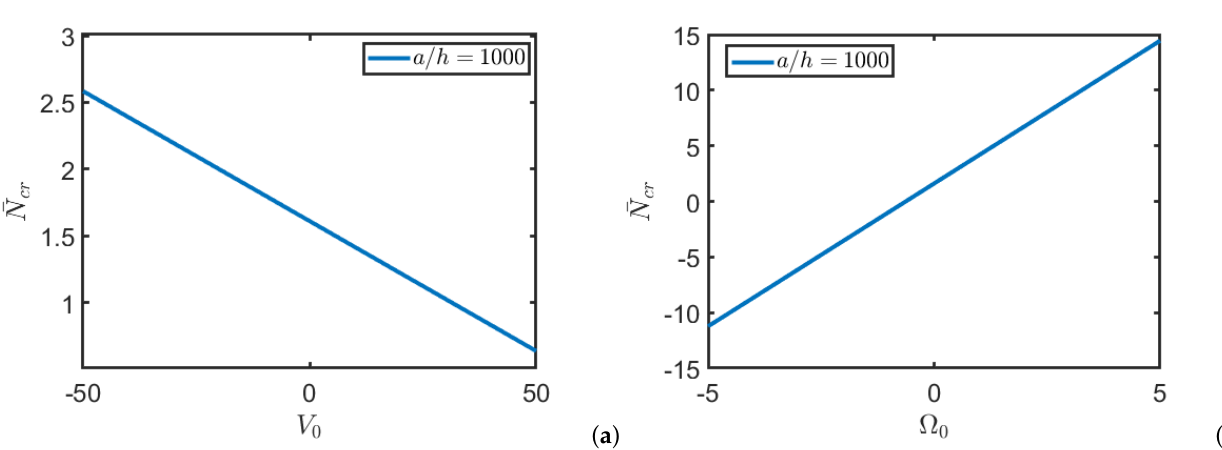
Figure 2. Critical load ¯ N cr of a square Functionally Graded (FG) nanoplate for different values of electric potential V 0 ( a ) and magnetic potential Ω 0 ( b